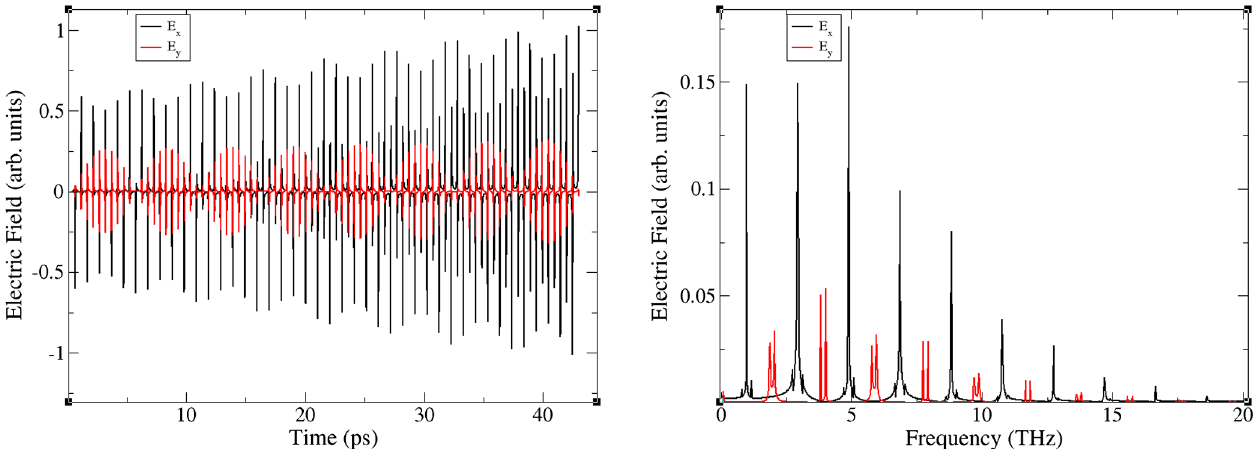
FIG. 5. Temporal profile and spectrum of radiation emitted by an electron injected off-axis in an undulator with K ¼ 2 . 5